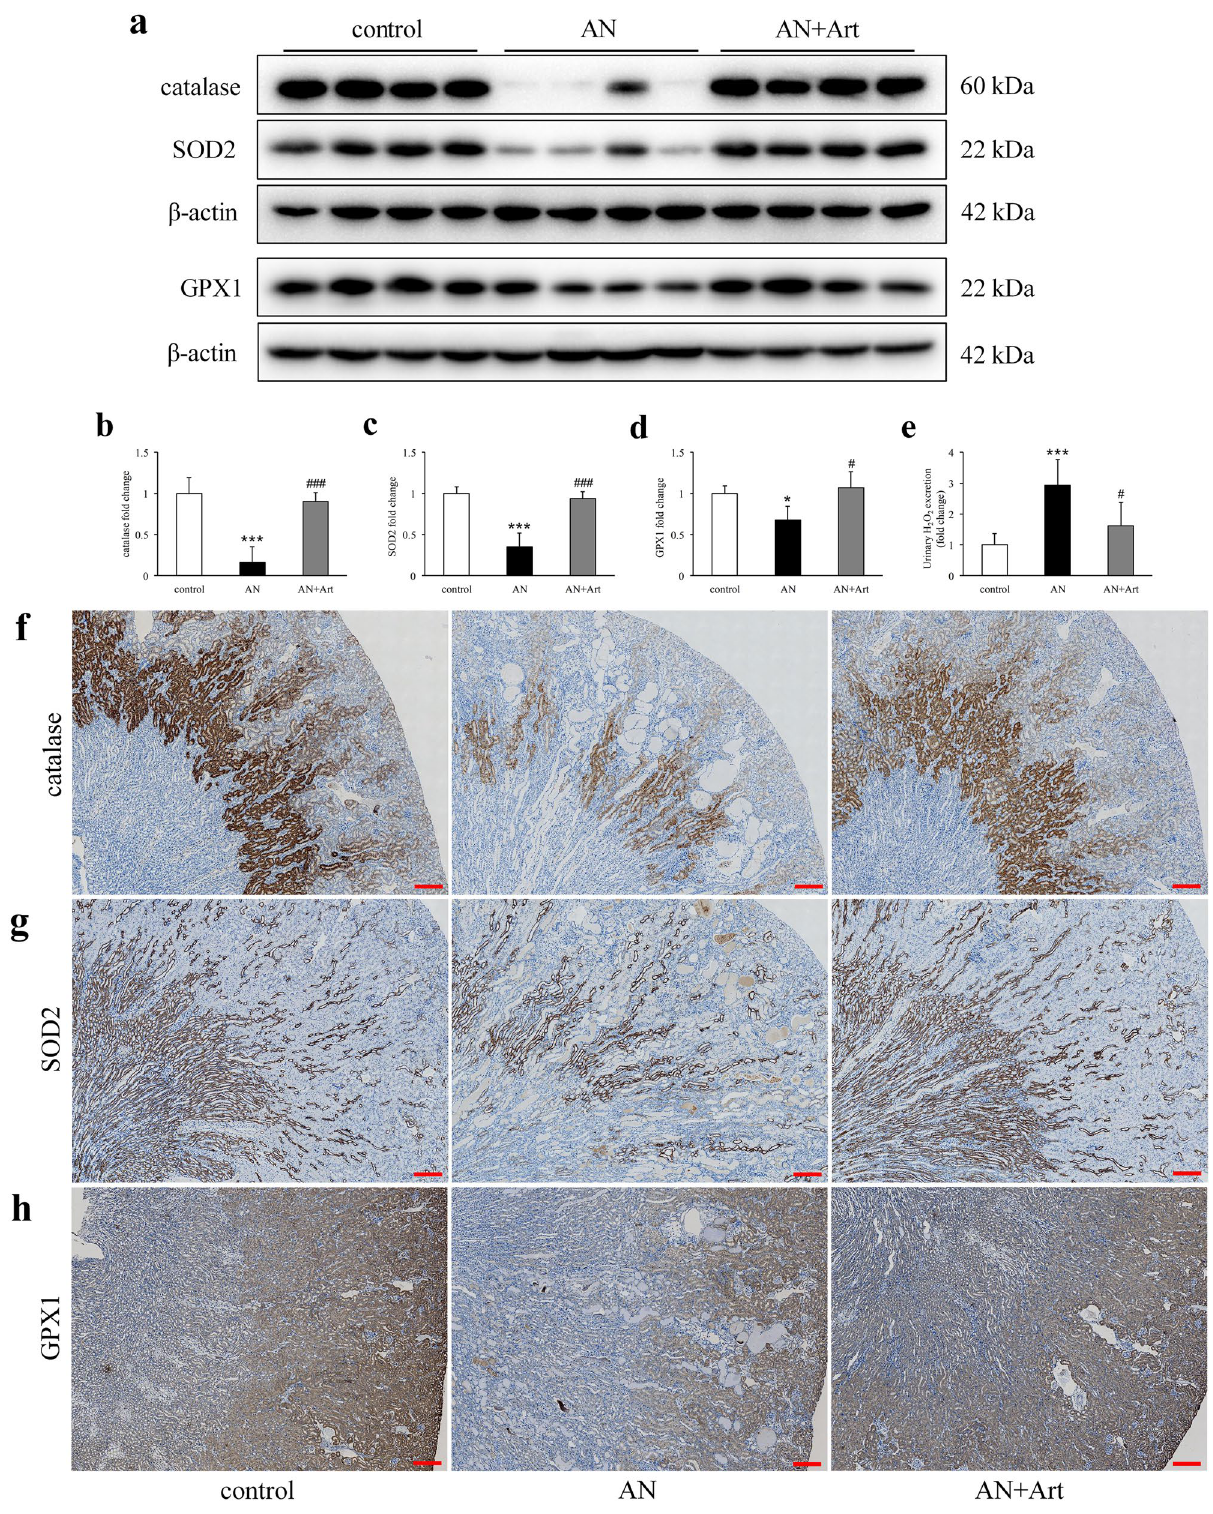
Figure 6. Effects of artemether on kidney redox balance and urinary H 2 O 2 excretion. ( a ) Western blot images displaying renal protein levels of catalase, SOD2, and GPX1 in each group. ( b – d ) Bar graphs showing the fold change of these proteins after normalization to β-actin. n = 4 per group. ( e ) Urinary H 2 O 2 excretion in various groups. n = 6 per group. ( f – h ) Representative immunostaining images of renal catalase, SOD2, and GPX1 in each group. Scale bar, 200 μm. * P < 0.05 and *** P < 0.001 versus control; # P < 0.05 and ### P < 0.001 versus